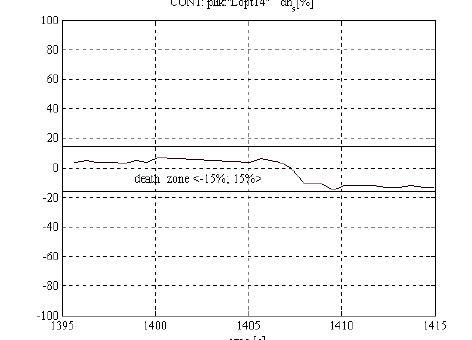
Fig 8. In the case of the control law with the pitch angle regulator, the pilot did not need to move the stick outside its dead zone to stabilize the altitude